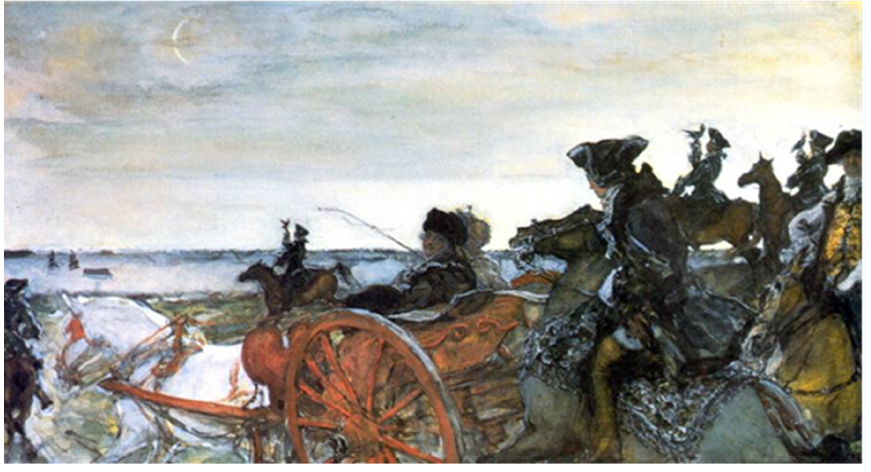
Figure 16. Valentin Serov. “Catherine II Setting out to Hunt with Falcons” (1902).